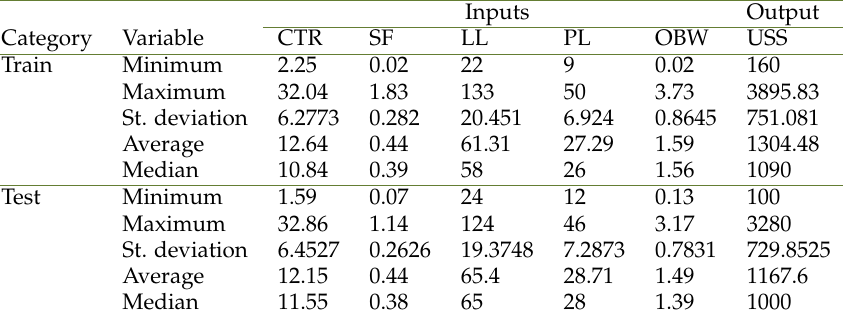
Table 1. The statistical values of the input and output variables Inputs Output